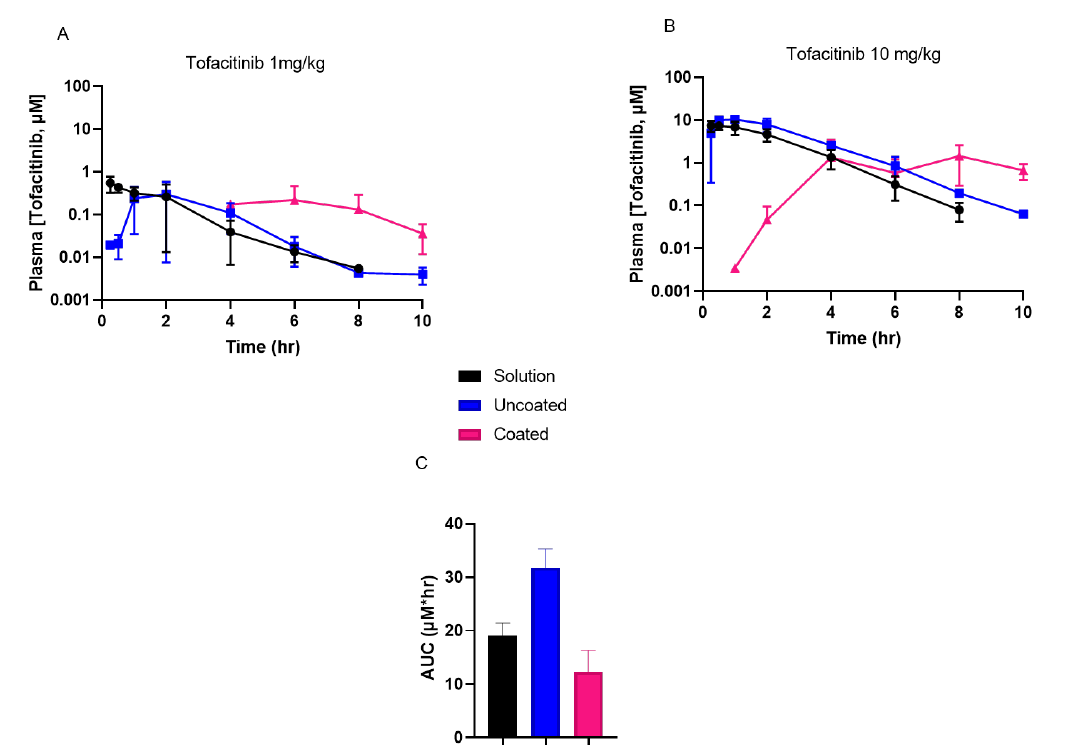
Figure 3. ( A , B ): Tofacitinib plasma concentrations recorded in rats following oral administration of a solution, uncoated capsules, and coated capsules dosed at either 1 mg/kg ( A ) or 10 mg/kg ( B ) tofacitinib. ( C ): Area under the curves (AUCs) of the 10 mg/kg tofacitinib formulations’ plasma concentration – time results (from data shown in ( B )). AUC solution vs uncoated p ≤ 0.0269 and coated vs. uncoated p ≤ 0.0011. C max solution vs. coated p ≤ 0.0210 and uncoated vs coated p ≤ 0.019.